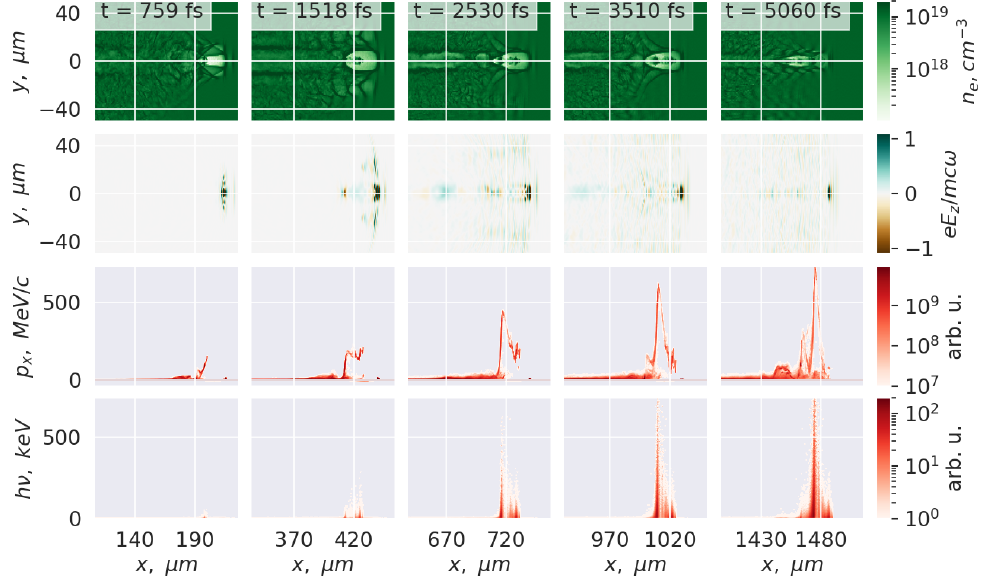
Figure 5. Simulation results for a Gaussian laser pulse with a duration of 11 fs with a 5-fs prepulse. The amplitude of the main pulse is a 0 = 7.1 and the amplitude of the prepulse is a 0 = 1.6. The data shown is similar to Figure 1. Note, however, the different scales of the electron momentum and photon energy.